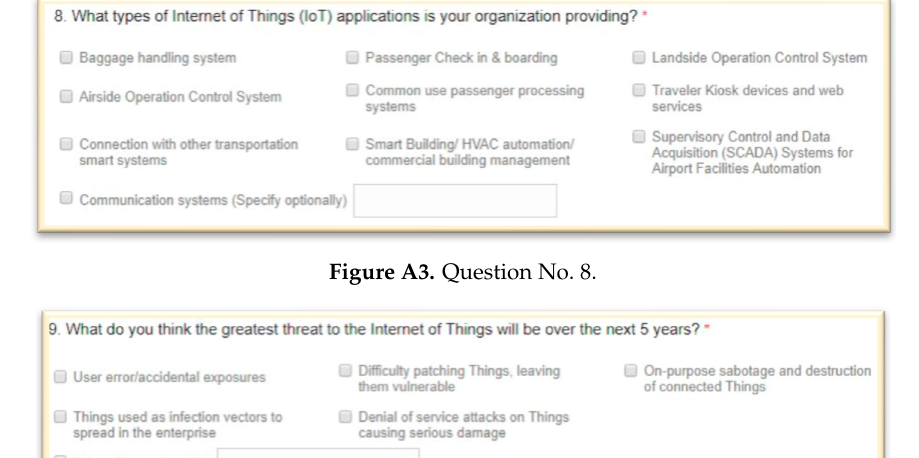
Figure A4. Question No 9.